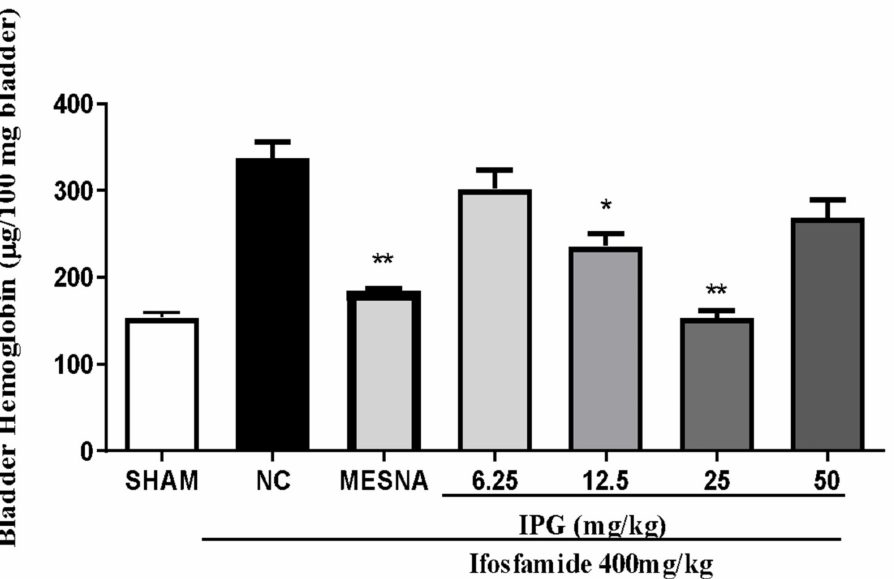
Figure 5. Effect of IPG on decreased bladder hemoglobin levels in animals with ifosfamide-induced hemorrhagic cystitis. Data are expressed in µ g of hemoglobin per 100 mg of tissue in the mean ± SEM format ( n = 6). Data were compared with the negative control (Tween/saline), by one-way analysis of variance (ANOVA), followed by the Bonferroni test; * p < 0.05, ** p < 0.001.